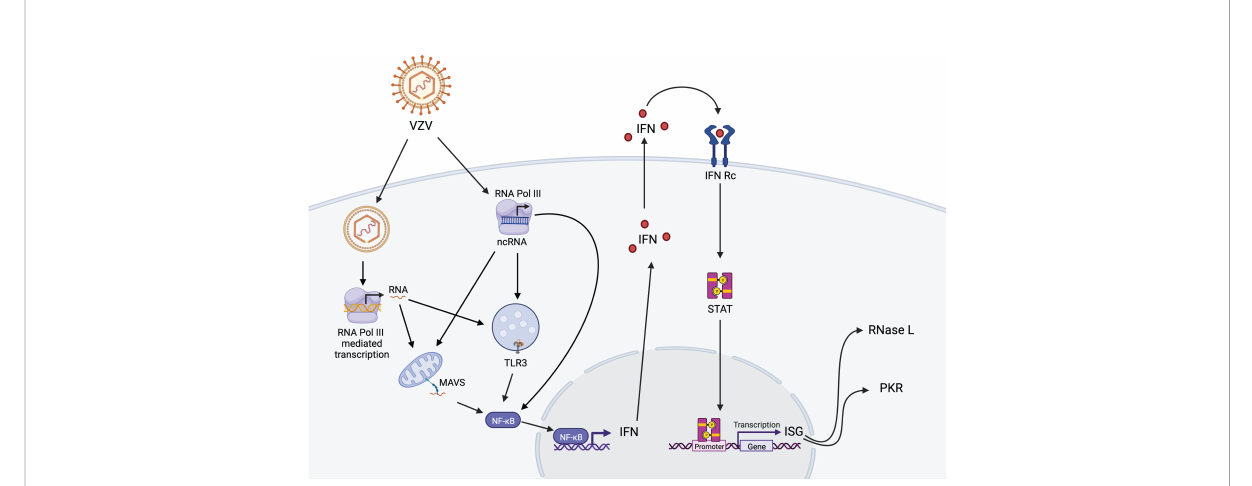
FIGURE 4 Proposed model of RNA Pol III-dependent activation of anti-VZV innate immune responses in lung epithelial cells. VZV DNA can be detected in the cytoplasm by cytosolic Pol III leading to activation of MAVS-dependent RIG-I pathway and TLR-3 pathway, which are also engaged by transcription of ncRNAs by cytosolic Pol III. Activation of these pathways results in translocation of NF-KB into the nucleus leading to interferon (IFN) response and activation of interferon-stimulated genes (ISG) RNase L and PKR in the initial host response against VZV infection. Figure generated on